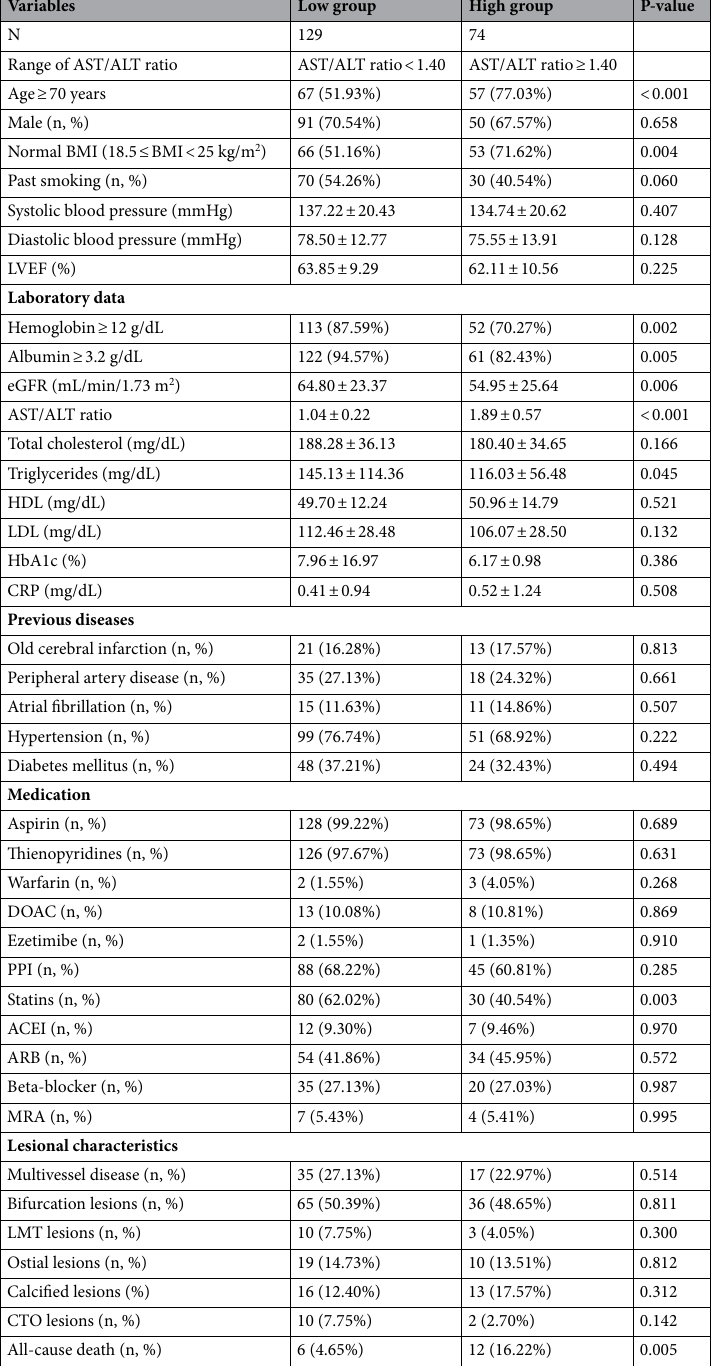
Table 1. Baseline characteristics of the two groups. Continuous variables are described by mean and standard deviation, and categorical variables are described by number of cases and percentage. BMI body mass index, eGFR estimated glomerular filtration rate, HDL high density lipoprotein, LDL low density lipoprotein, HbA1c hemoglobin A1c, CRP C-reactive protein, LVEF left ventricular ejection fraction, DOAC direct oral anticoagulants, PPI proton pump inhibitor, ACEI angiotensin-converting enzyme inhibitor, ARB angiotensin- receptor blocker, MRA mineralocorticoid receptor antagonist, MACE major adverse cardiac events, CTO chronic total occlusion, DES drug-eluting stent, LMT left main